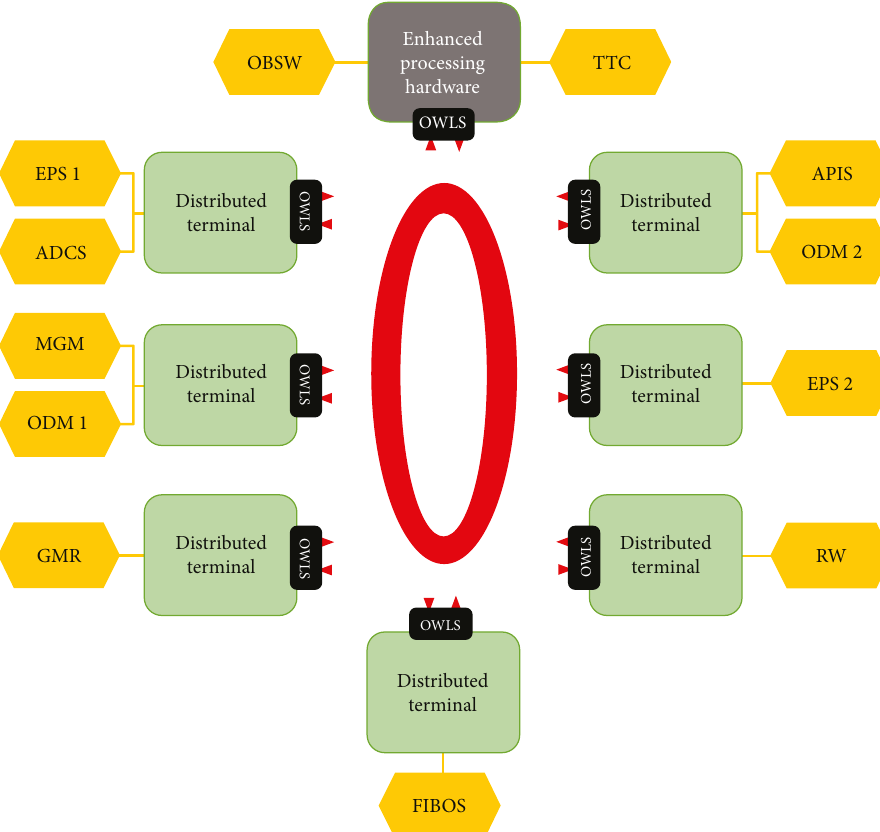
Figure 3: OPTOS On-Board Computer Top-Level Architecture. (OPTOS S/S: EPS (Electronic Power Subsystem); ADCS (Attitude Determination and Control Subsystem) which comprises a set of magnetometers (MGM), a reaction wheel (RW), and several sun sensors; On-Board Communications based on OWLS; TTC (Telemetry/Telecommand and Control); OBSW (On-Board SoftWare) comprising the Application and Boot Software; and the OBC itself. OPTOS P/L: radiation monitor based on RadFETs (ODM), a novel magnetometer based on giant magnetoresistance (GMR), Fiber Bragg Grating for optical sensing (FIBOS), and an Athermalized Panchromatic Image Sensor